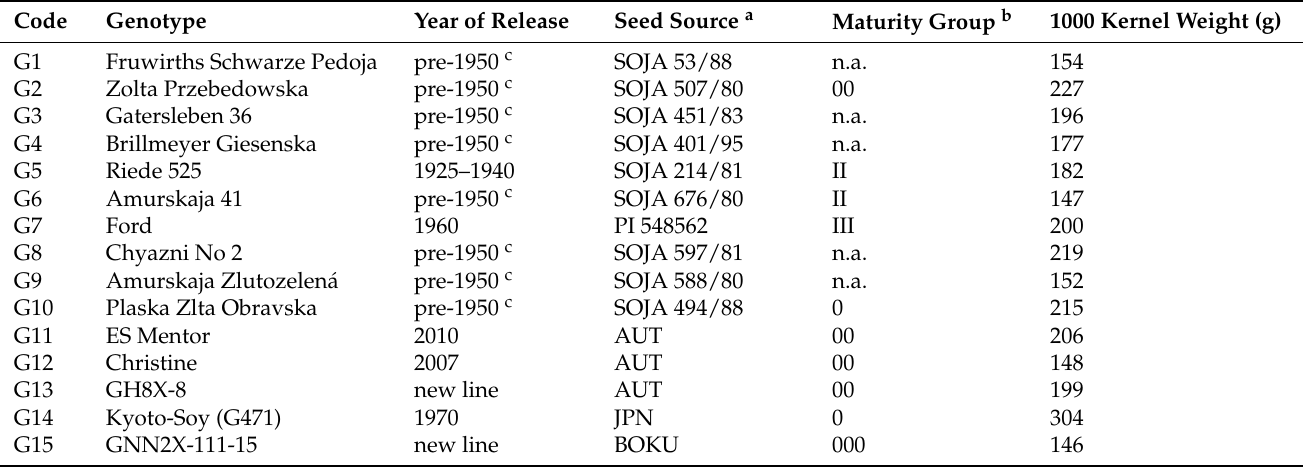
Table 1. Characteristics and origin of the soybean germplasm used in the